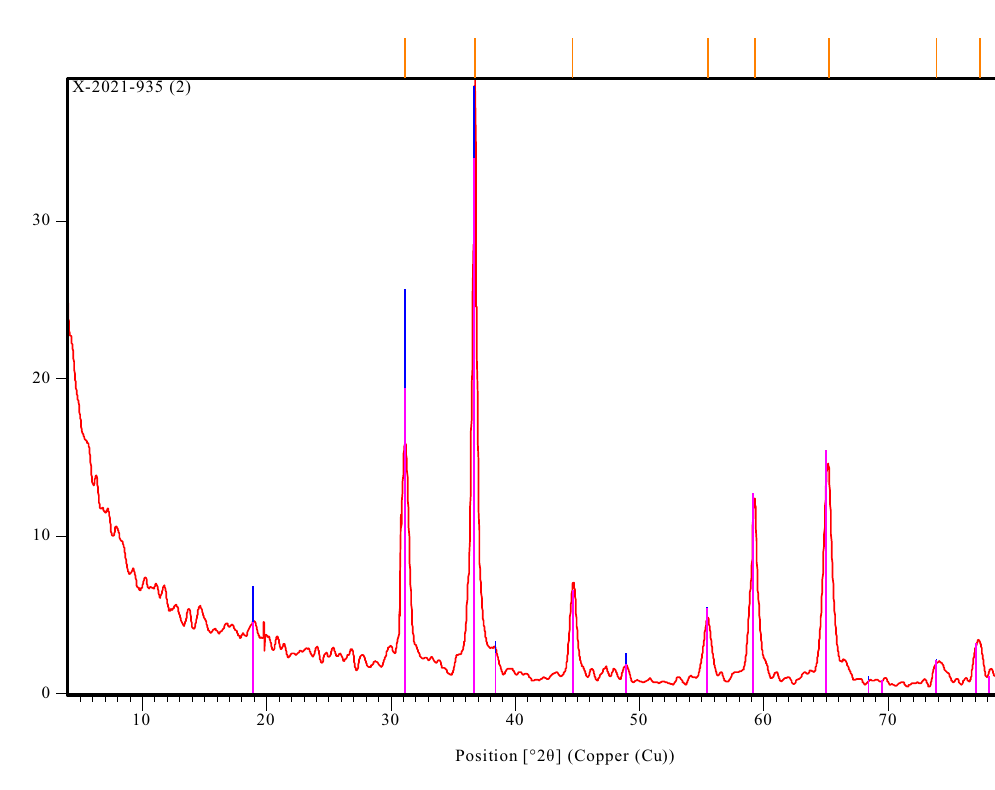
Figure 5. X-Ray Diffraction of Nano CoAl 2 O 4